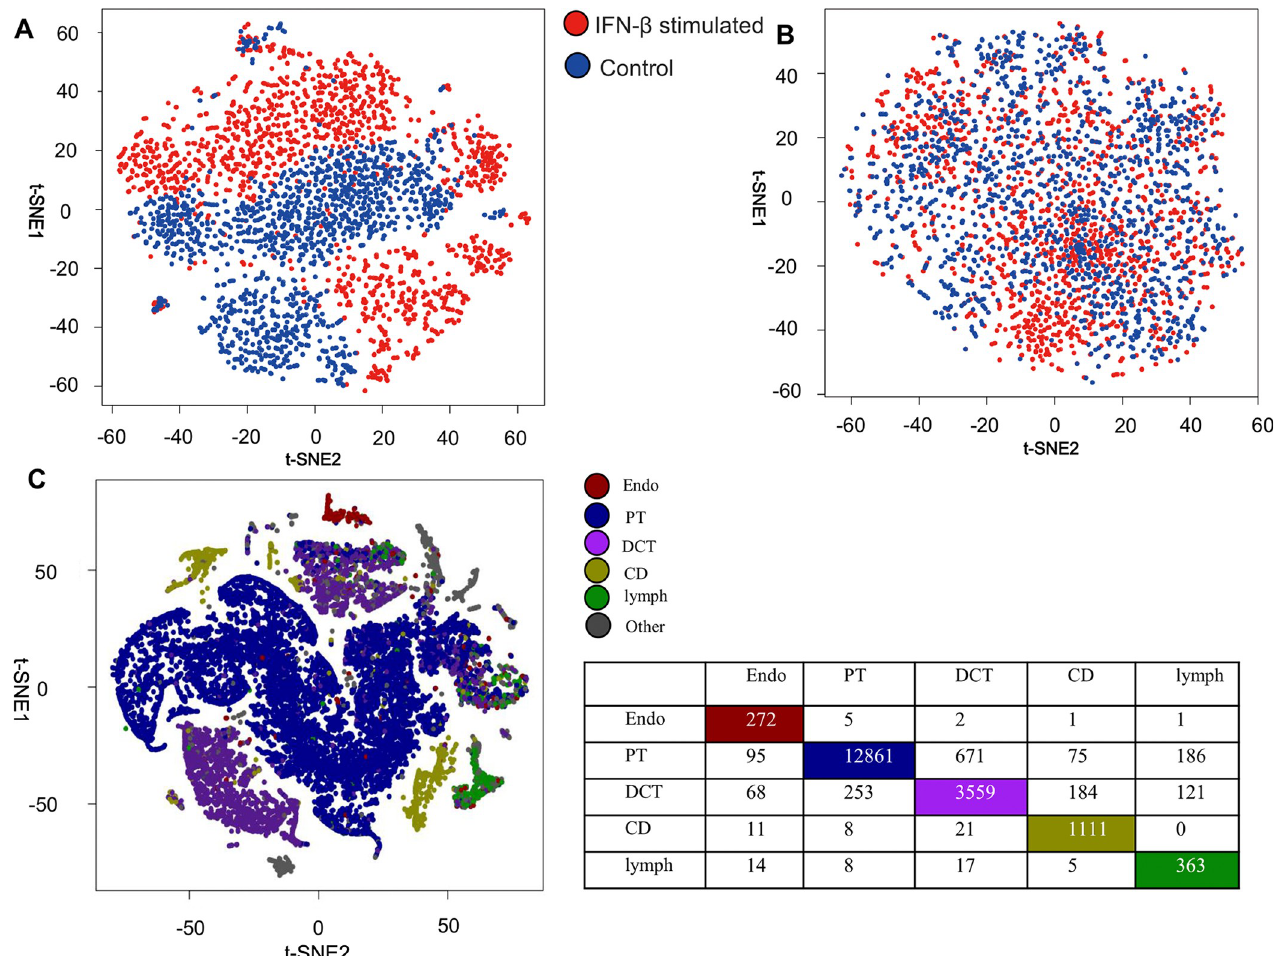
Fig 3. Accurate cell type identification by COAC. ( A ) The IFN- β stimulated and control groups are separated based on the subnetworks identified by COAC. ( B ) Cells from IFN- β stimulated and control groups are uniformly distributed in the whole space without applying COAC. ( C ) Five different cell types are identified with high accuracy based on gene subnetworks identified by COAC. Cell types for 83.05% cells have been identified correctly based on well-defined cell types from experimental data. Cell types are visualized by a t-SNE algorithm [9]. Endo: endothelial cells, PT: proximal tubule cells, DCT: distal convoluted tubule cells, CD: collecting duct principal cells, lymph: lymphocyte